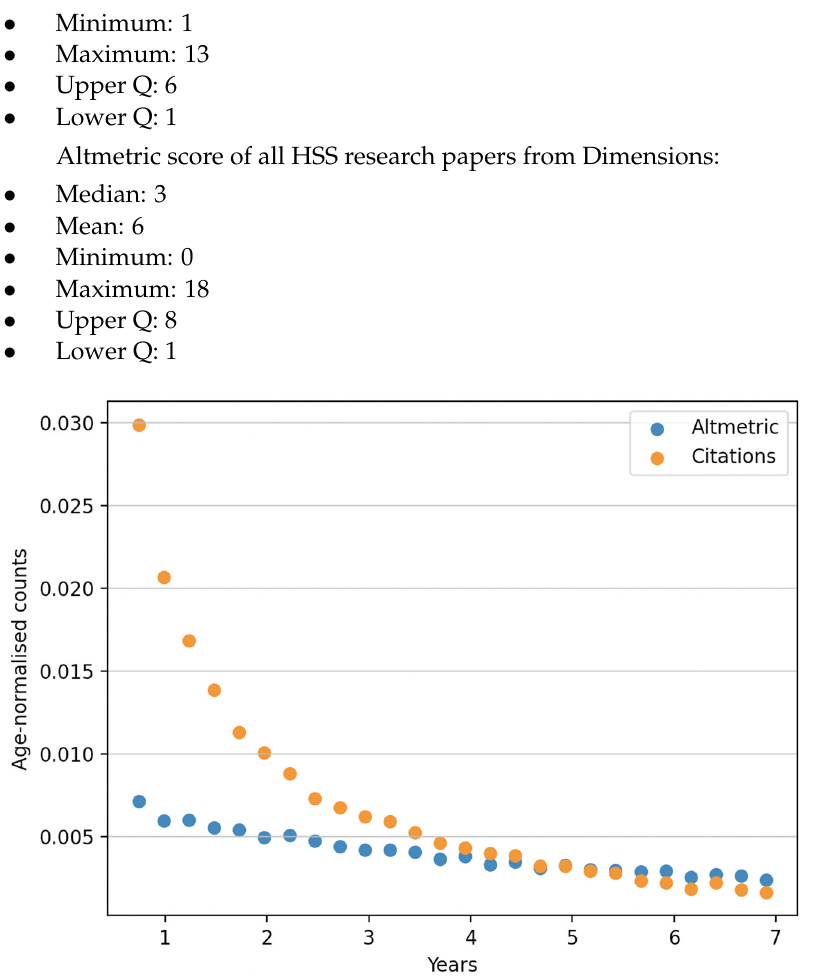
Figure A15. Humanities and social sciences research papers from Dimensions (2015–2022): average total citations and Altmetric scores over time (3-month ranges).